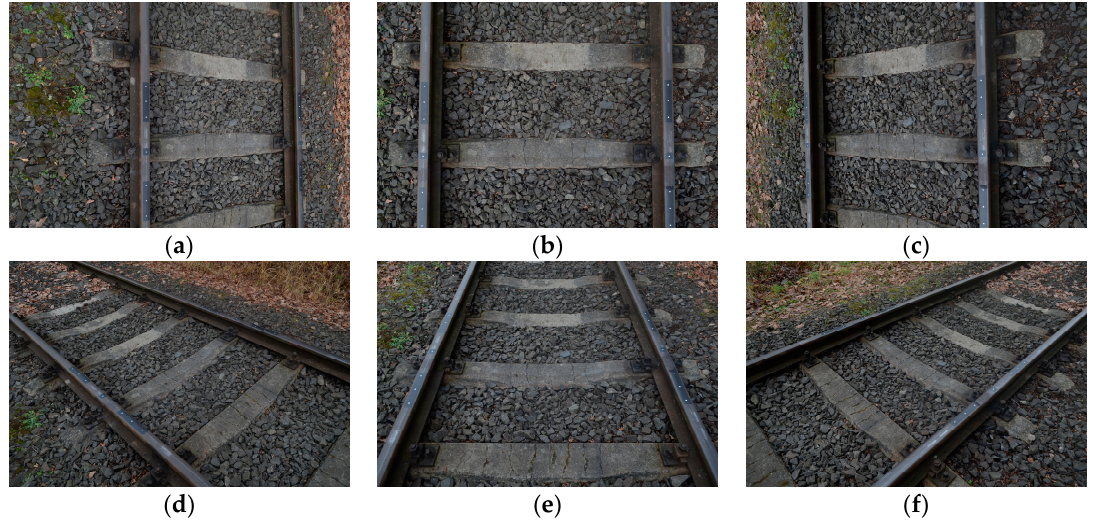
Figure 2. Configuration of six terrestrial photos of the tested section of the track: nearly vertical photo ( b ), oblique photos ( a , c , e ), and oblique–convergent photos ( d , f